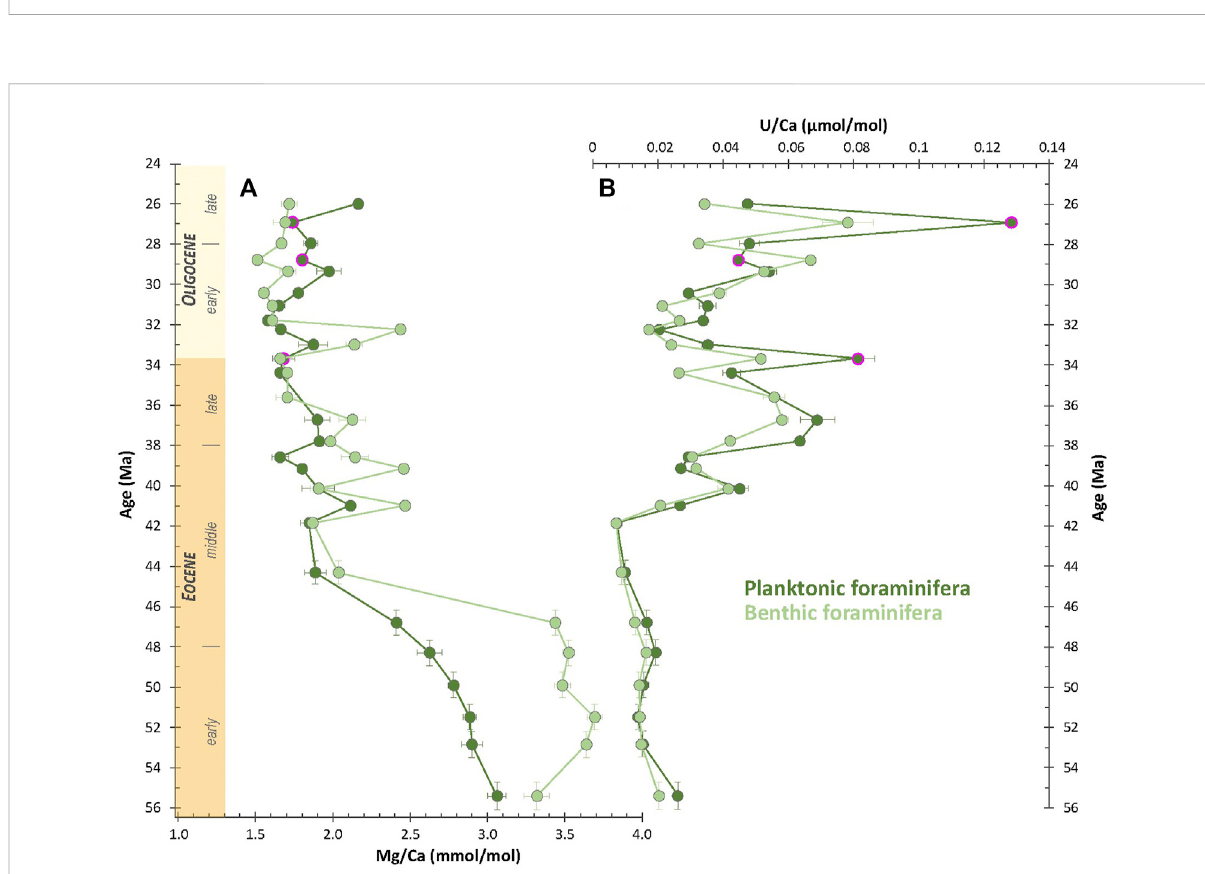
FIGURE 6 Temporal evolution of (A) Mg/Ca molar ratios (in mmol.mol − 1 ) and (B) U/Ca molar ratios (in µmol.mol − 1 ). Samples highlighted in pink are the three samples slightly above the contamination threshold for Al/Ca and Sr/Ca molar ratios (see Figure 5).